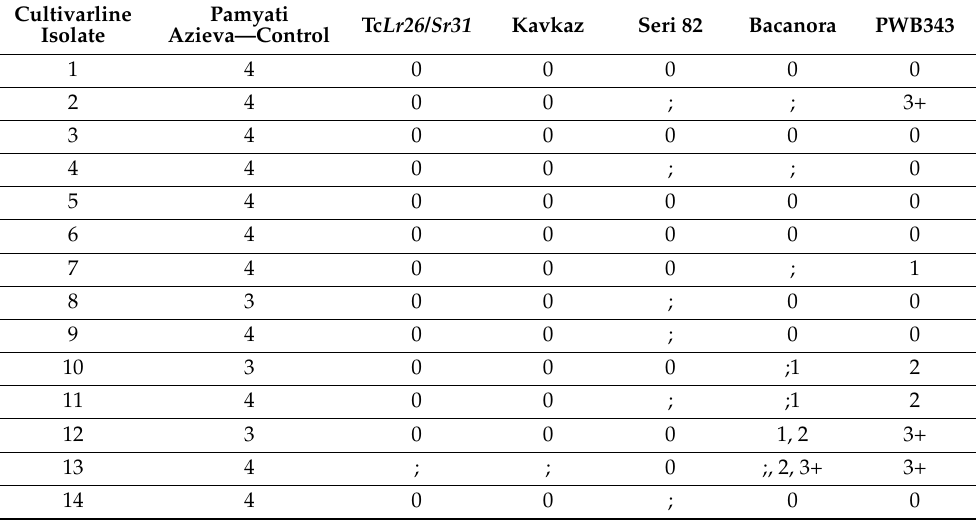
Table 2. Results of laboratory evaluation of T. aestivum seedlings’ reactions to infection of. P. graminis f. sp. tritici isolates, infection